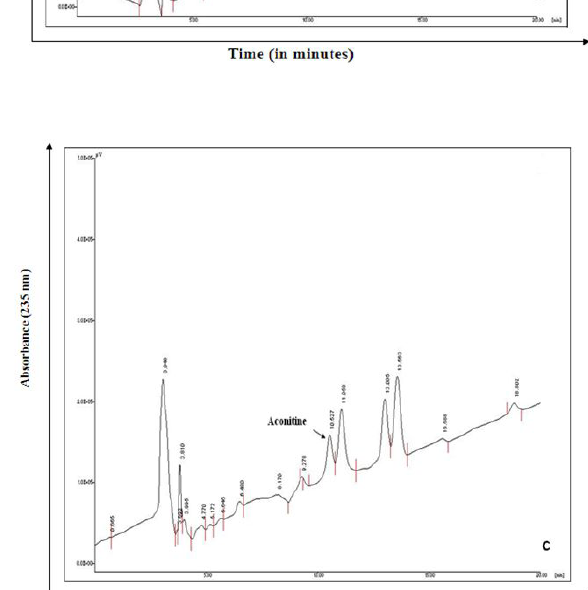
Fig. 3. HPLC profile of a. standard aconitine; b. A. nagarum root; c. A. elwesii